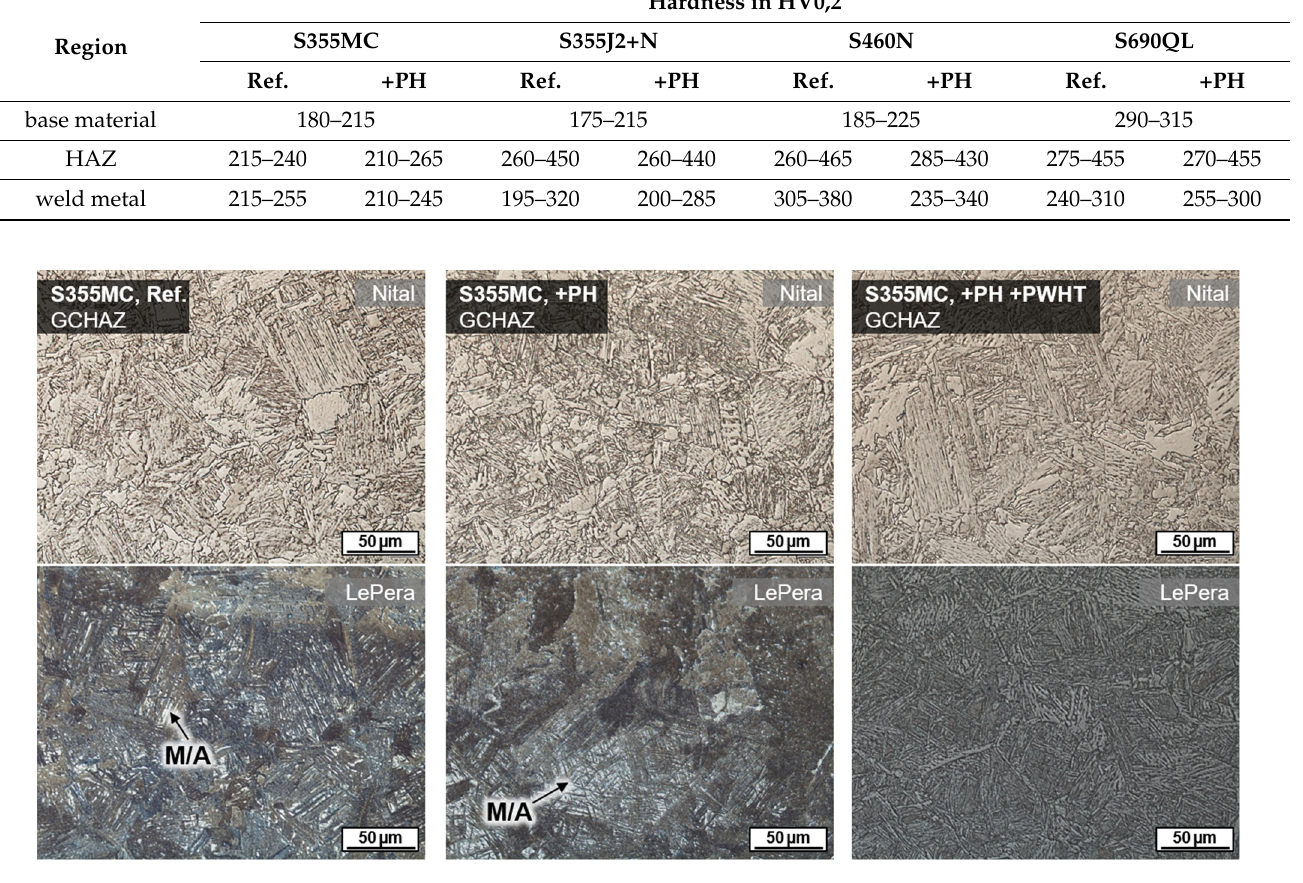
Figure 9. Microstructure in GCHAZ of wet SMAW on S355MC ( WD = 0.5 m): Reference without induction heating ( left ), with additional PH ( center ), and with combined PH and PWHT ( right ); induction heating each 60 s, 100% induction power, moving induction head on 100 mm length.